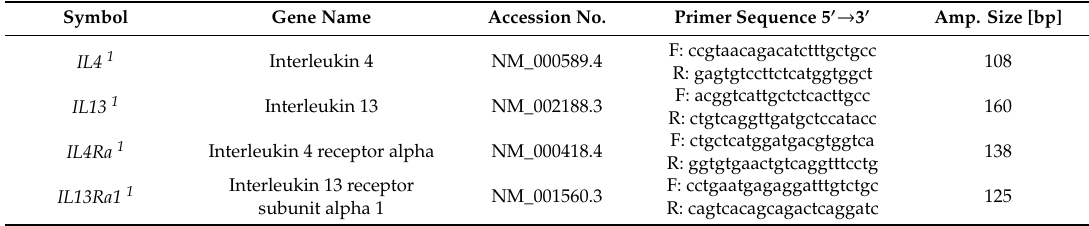
Table 12. Primers’